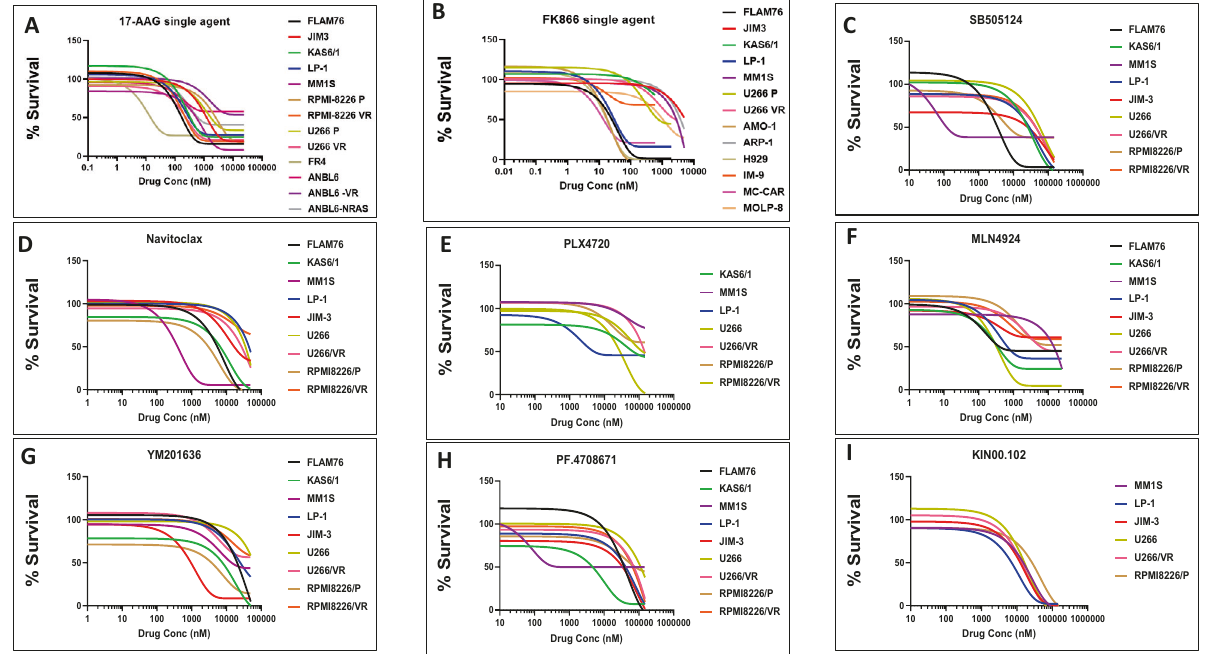
Fig. 1 secDrugs decrease in vitro cell viability in multiple myeloma. Single-agent dose-response plots for the secDrugs in HMCLs. A 17-AAG; B FK866; C SB505124; D Navitoclax; E PLX4720; F MLN4924; G YM201636; H PF.4708671; I speci fi c inhibitor (PF-4708671), and the neddylation inhibitor (MLN4924). Furthermore, when only the top PI-resistant cell lines (R; highest 33% PI IC 50 ) were considered, the following drugs were predicted to be highly effective: 17.AAG, PLX4720, YM201636, and the AKT inhibitor KIN001.102. Top secDrugs induce loss of viability in HMCLs as single-agent treatment First, we used our panel of HMCLs as in vitro validation screens to evaluate the top predicted secDrugs, including 17-AAG,